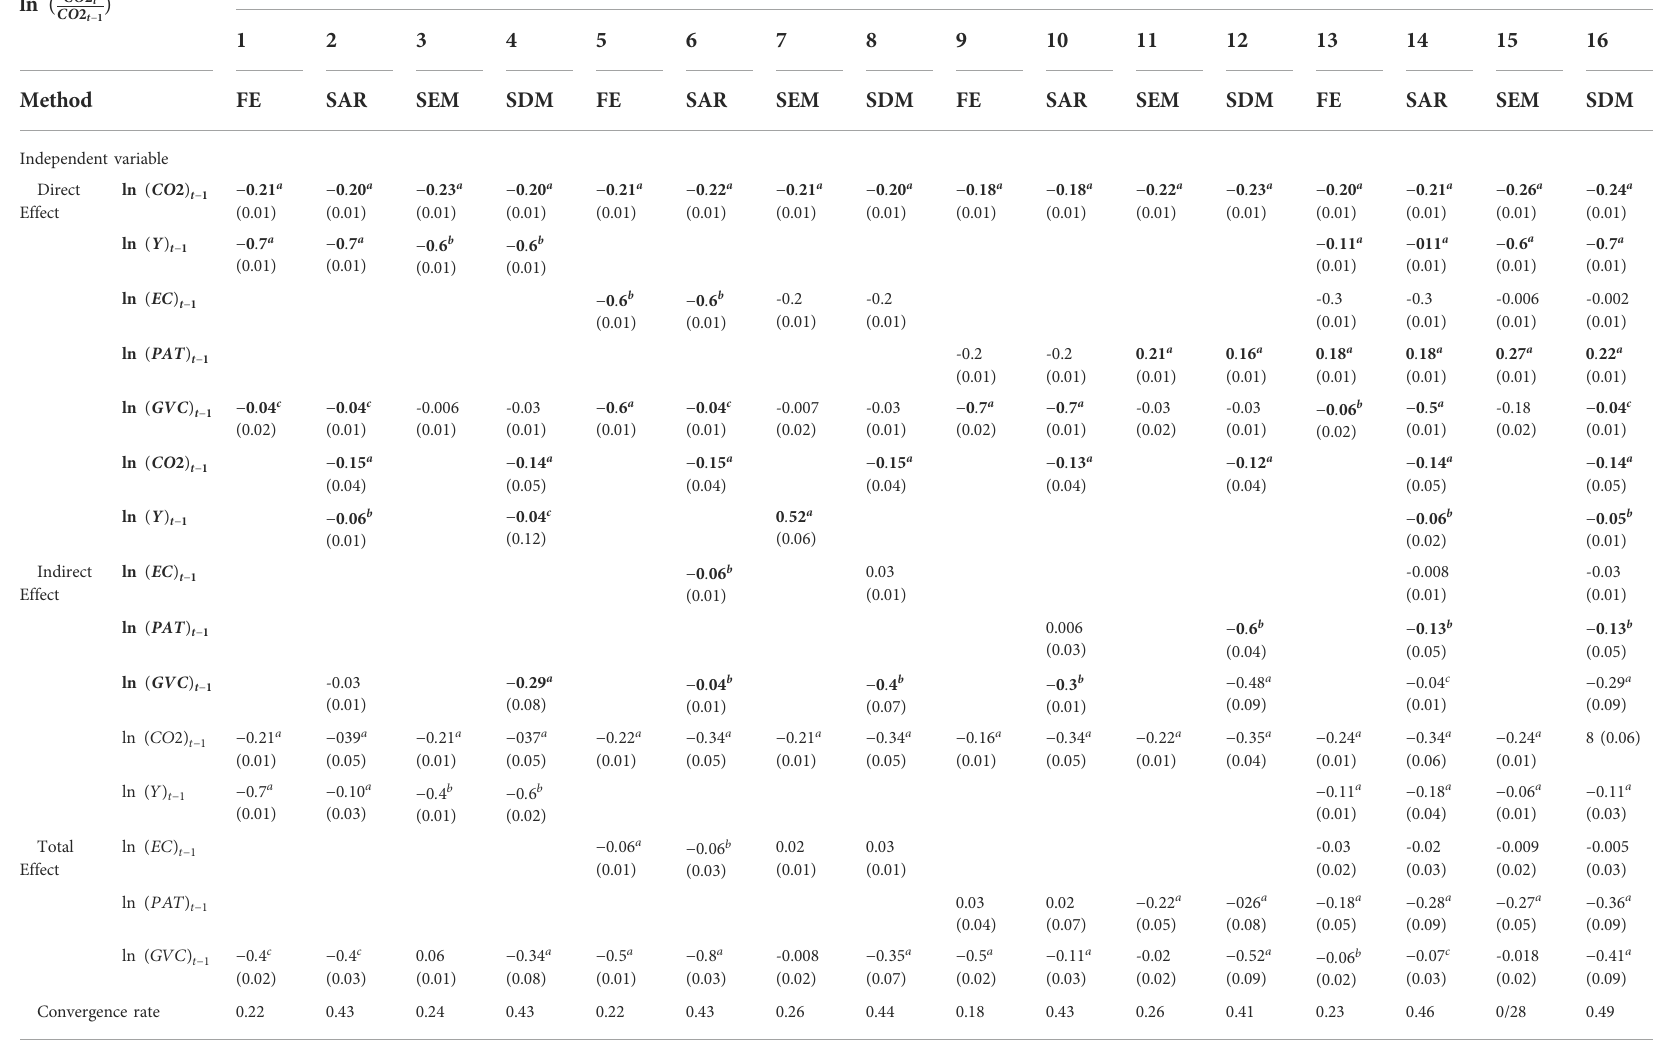
TABLE 6 Estimated direct effects, indirect effects, and total effects; and the conditional convergence of CO 2